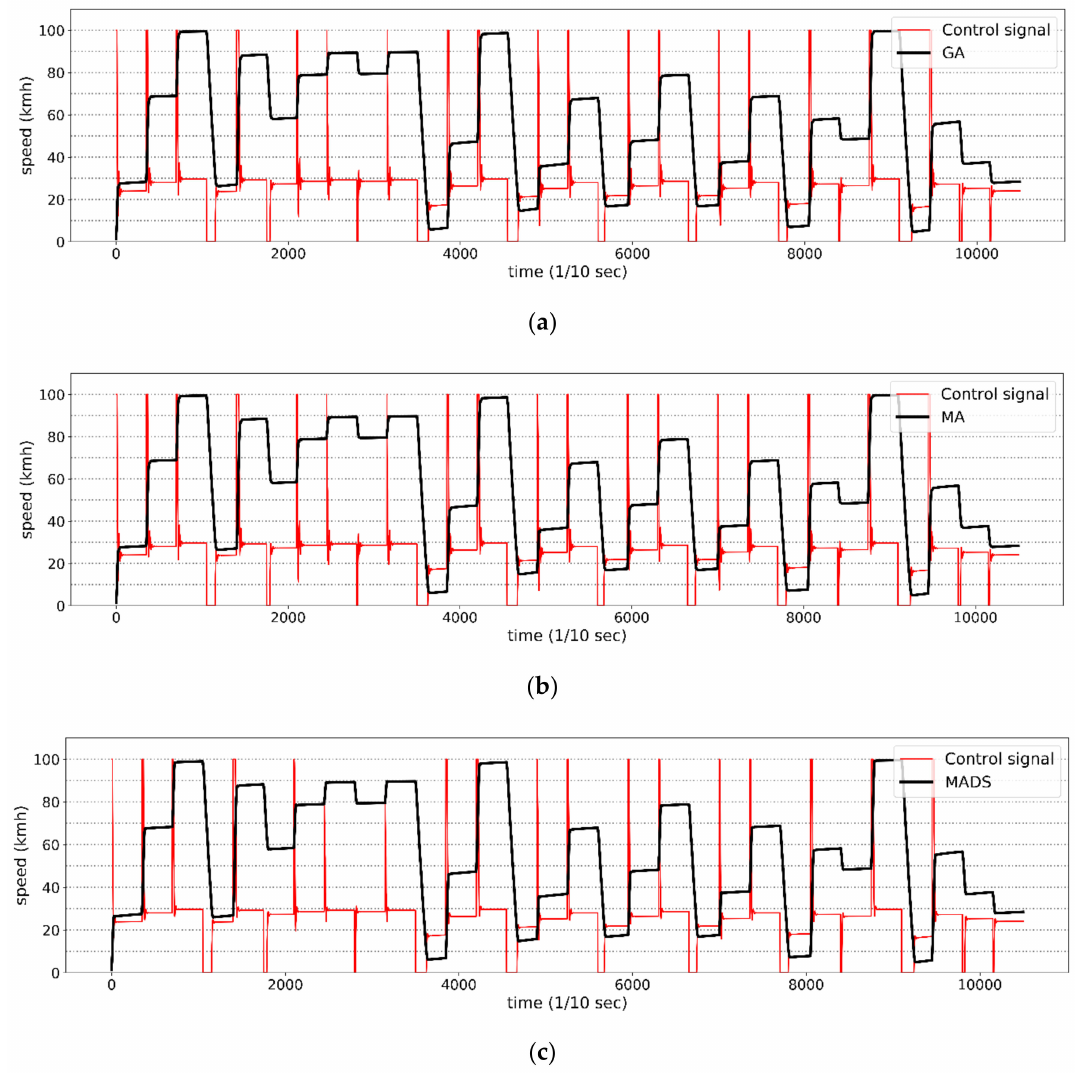
Figure 4. Representation of the performance of GA ( a ), MA ( b ) and MADS ( c ) optimized